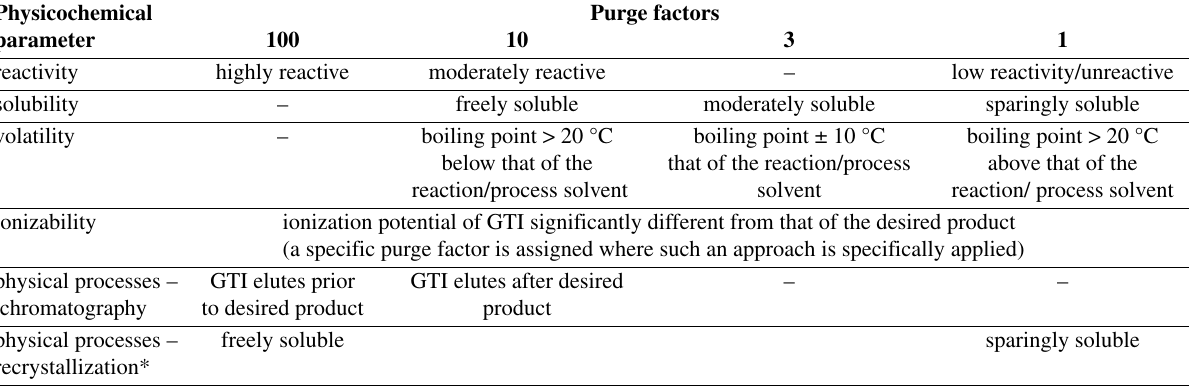
Table 3. Physicochemical parameters and associated purge factors (adapted from Teasdale et al. 8 )